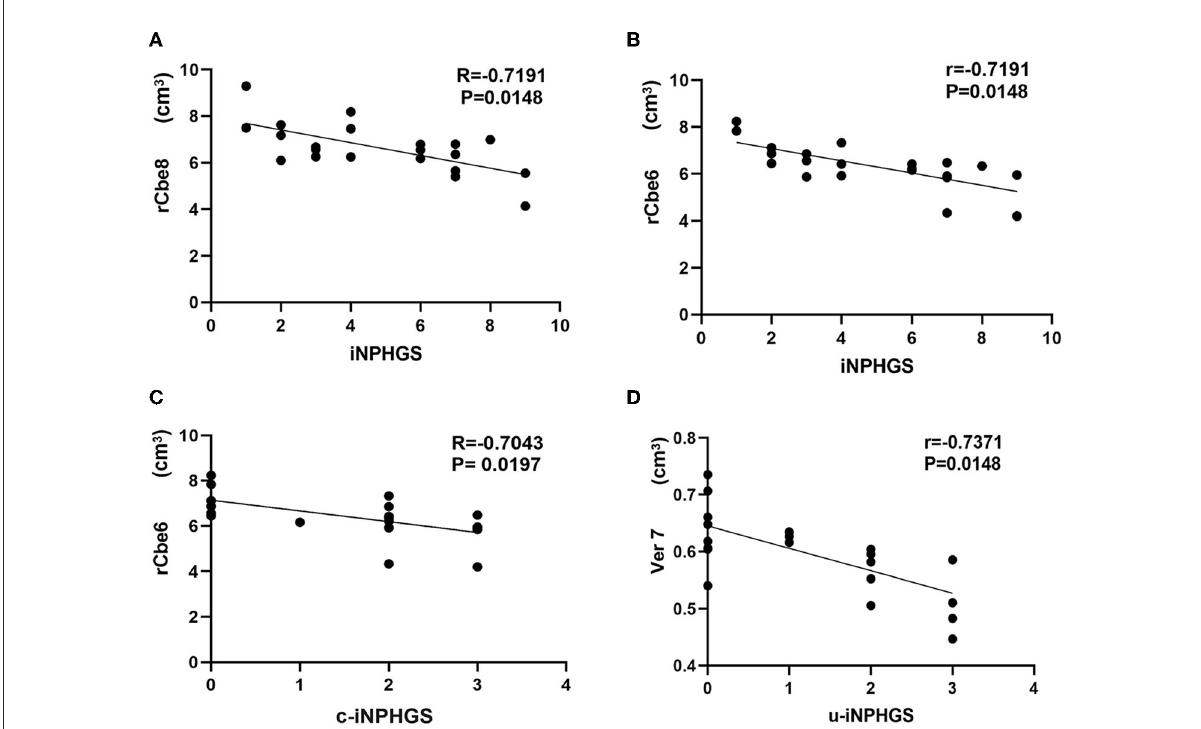
FIGURE4 Correlation analysis between different brain regions and the idiopathic normal-pressure hydrocephalus grading scale (iNPHGS). c-iNPHGS, cognitive-iNPHGS; u-iNPHGS, urinary control-iNPHGS; Cerebelum-8-R (rCbe8), Cerebelum-6-R (rCbe6), Vermis-7